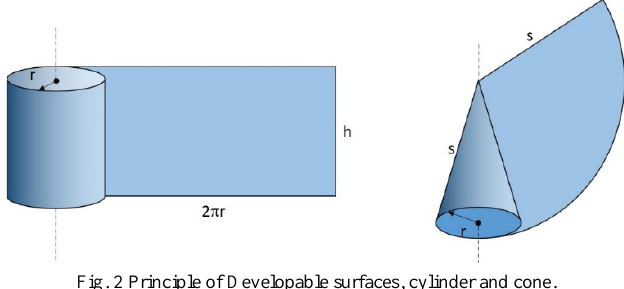
Fig. 2 Principle of Developable surfaces, cylinder and